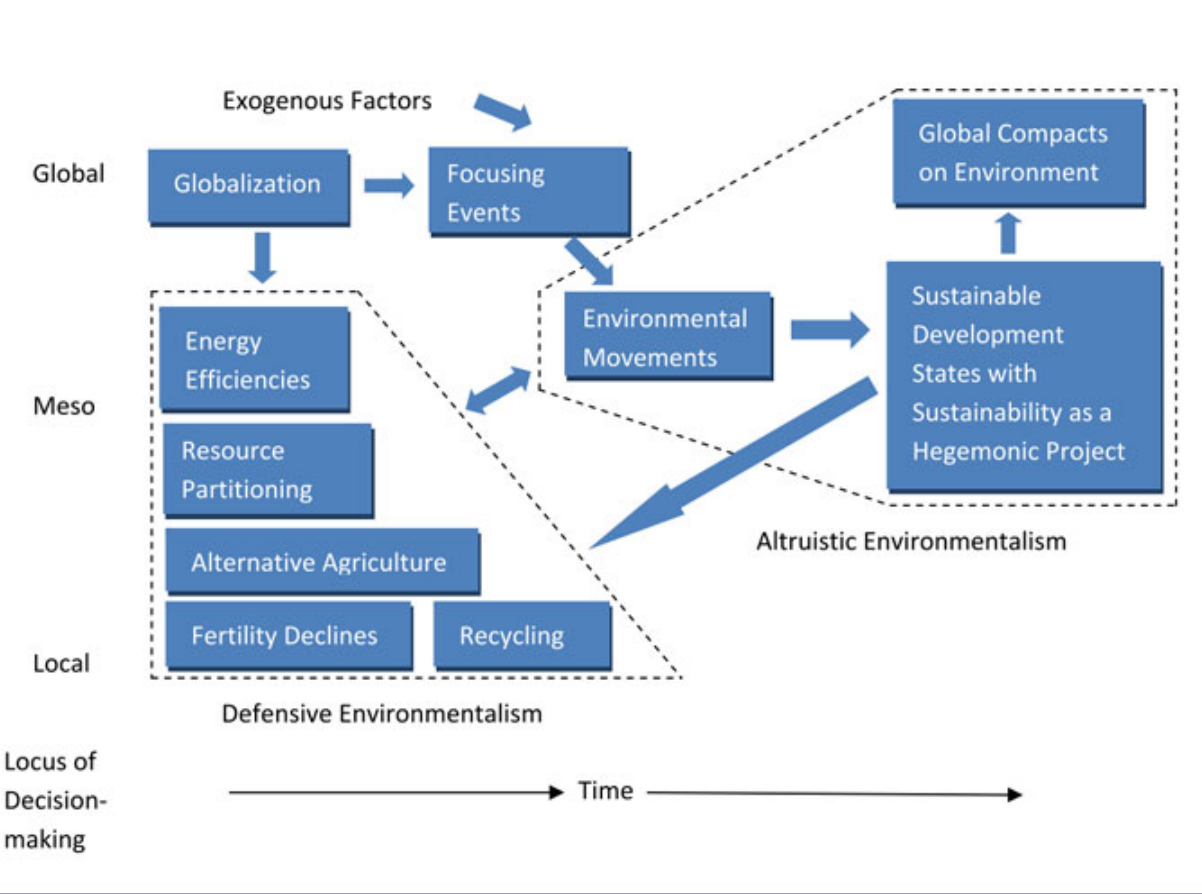
Fig. 1. Model of environmental